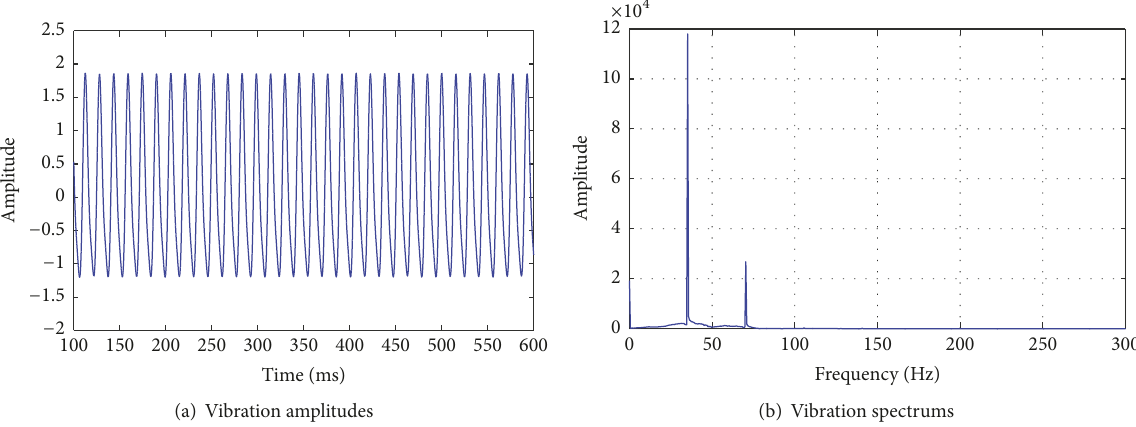
Figure 5: The horizontal direction response of the disk ( 𝜆 = 0.5 , 𝛿 = 0.00002 m).